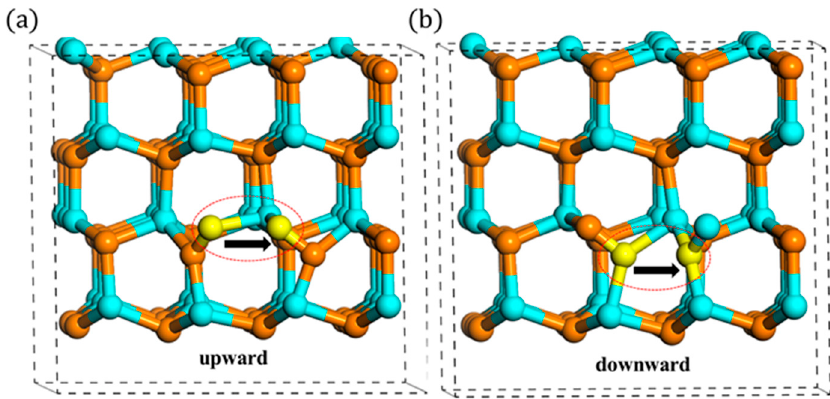
Figure 7. ( a ) Upward and ( b ) downward migration (the left yellow atom migrates to the right yellow atom).